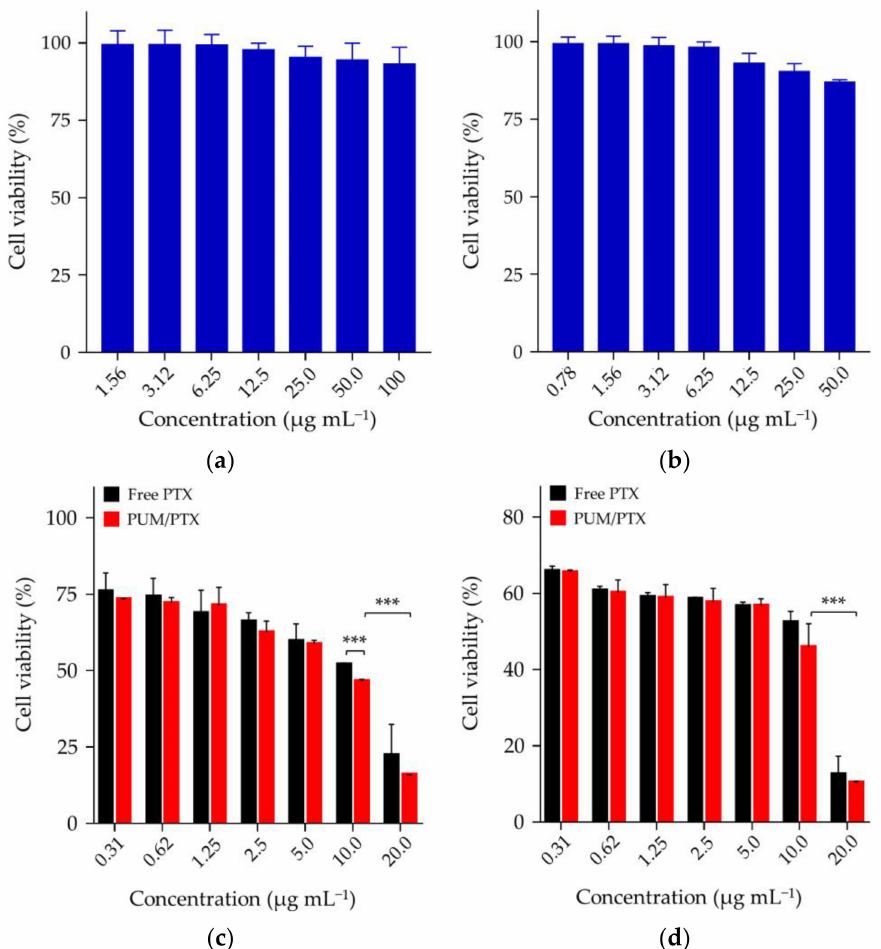
Figure 4. In vitro cytotoxicity of ( a ) L929 and ( b ) 4T1 cells in 72 h; ( c ) PUM / PTX in 48 h and ( d ) PUM / PTX in 72 h after incubation with 4T1 cells. The error bars represent the standard deviation ( n = 3; * p < 0.05, ** p < 0.01, *** p <